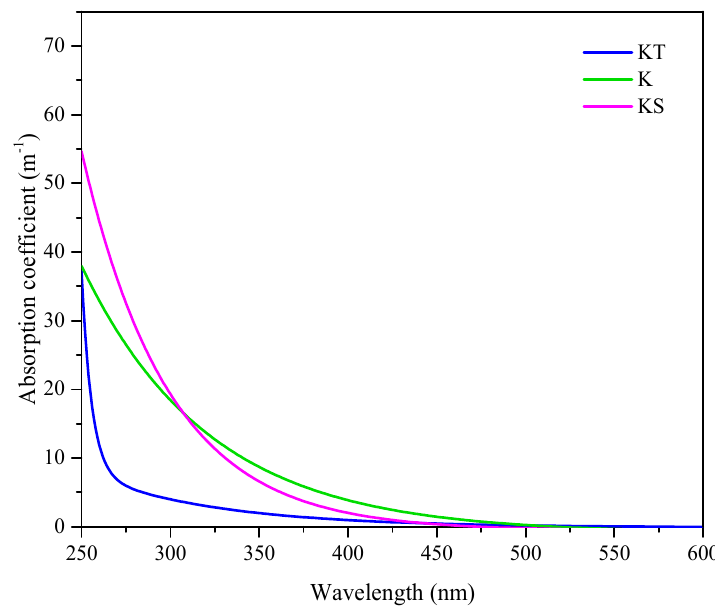
Figure 3. UV-Visible absorbance spectra of DOM of KT, K and KS in this study. Table 4. UV-visible and fluorescent spectroscopy indices of the DOM extracted from three sediments. UV-Visible Indices Fluorescent Indices Station SUVA 254 E 2 /E 3 E4/E